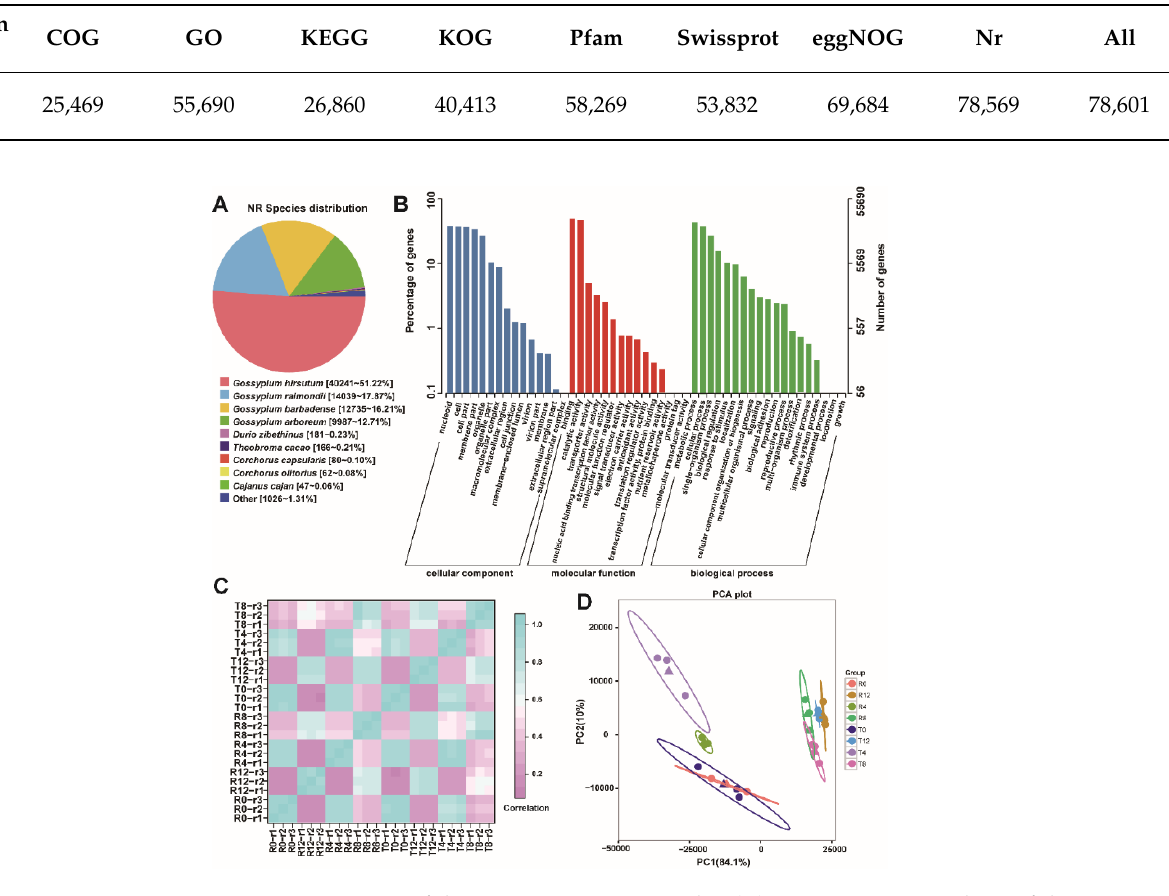
Figure 1. Overview of the ONT sequencing results. ( A ) Homogeneous analysis of the Nr species distribution; ( B ) GO term statistics of the annotated genes; ( C ) correlation between the samples; ( D ) principal component analysis of the samples.